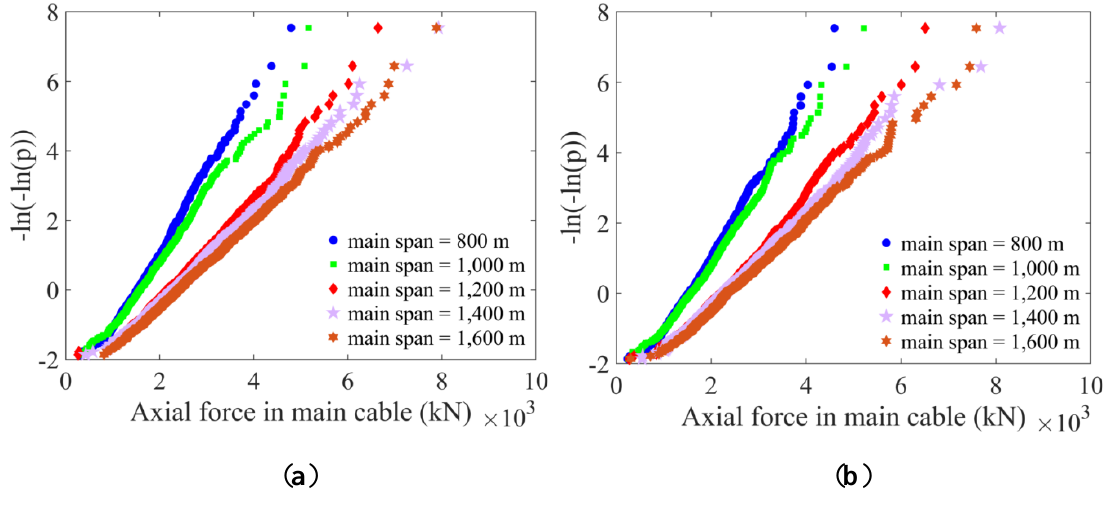
Figure 9. Probability paper plots of cable force for medium trucks / high flow (MTHF) for five bridge lengths: ( a ) maximum-per-hour; ( b ) maximum-per-day.